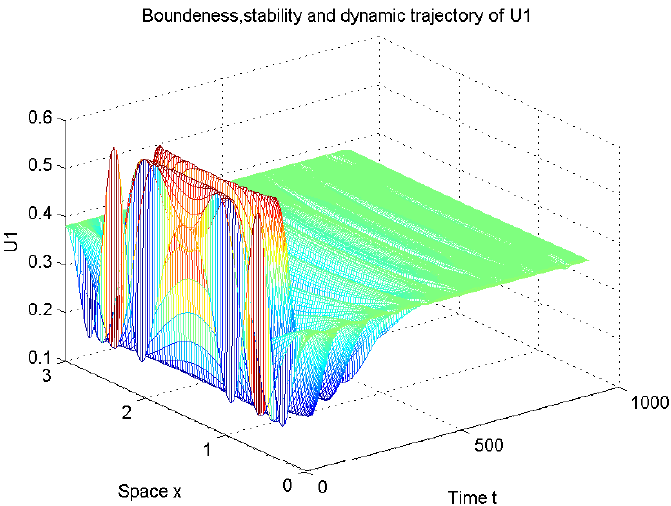
Figure 14. Computer simulation of dynamics of the interest rate U 1